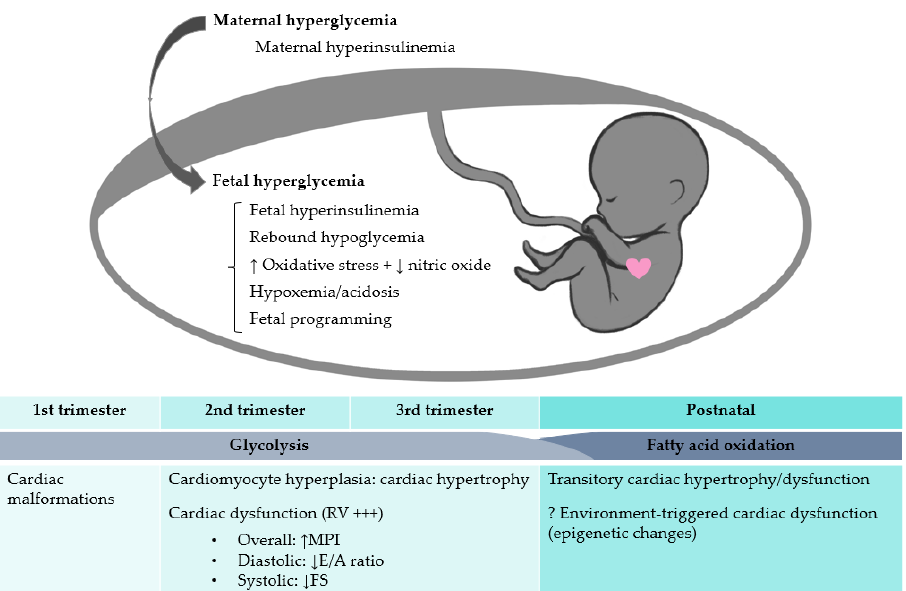
Figure 1. The effects of maternal hyperglycemia on the fetal heart. RV, right ventricle; MPI, myocardial performance index; FS, fractional shortening.